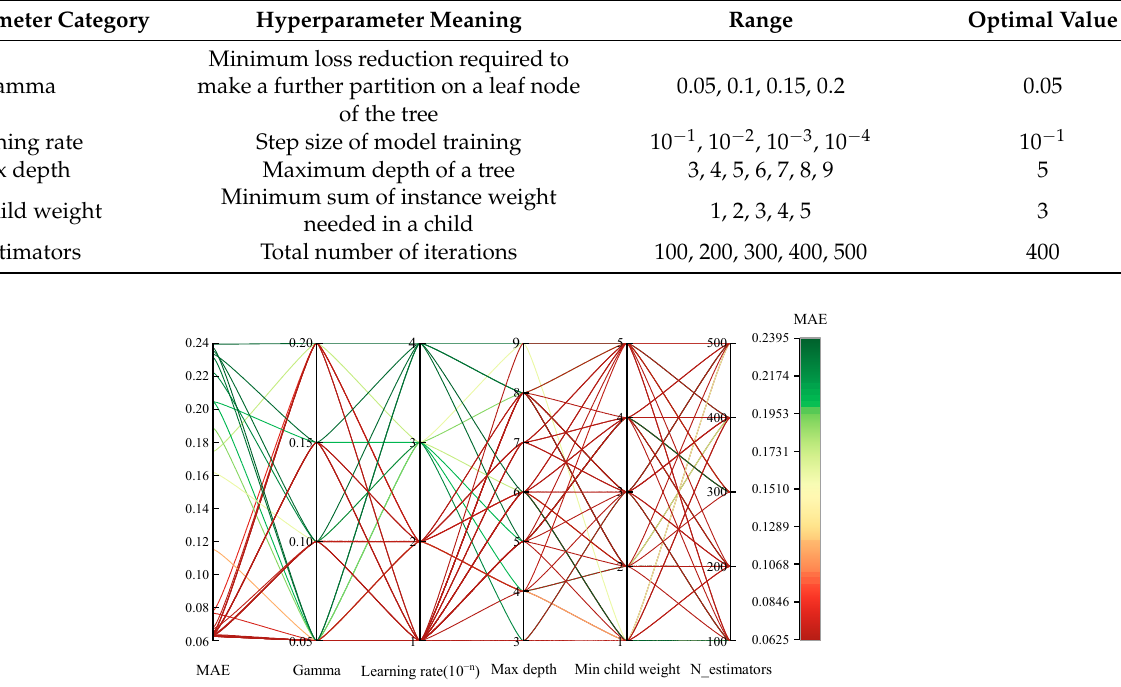
Figure 10. Hyperparameter optimization process for XGBoost.